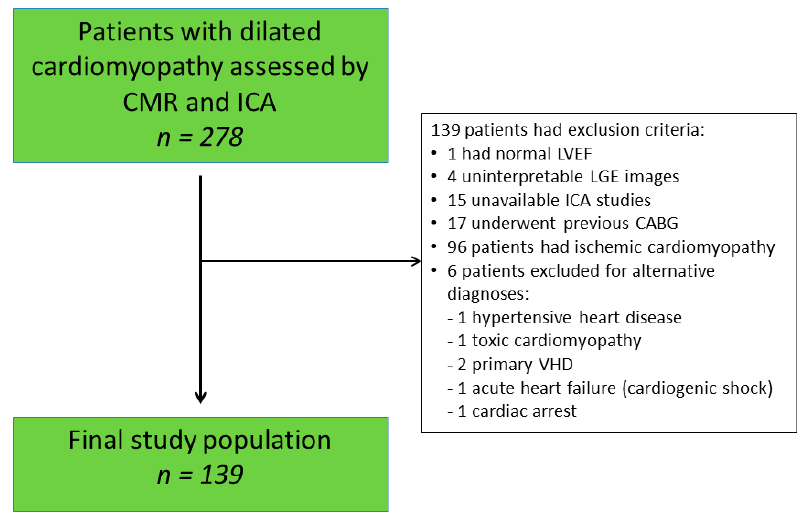
Figure 1. Flow chart of study. VHD: valvular heart disease. LVEF: left ventricular ejection fraction; CMR: cardiovascular magnetic resonance imaging; ICA: invasive coronary angiography; LGE: late gadolinium enhancement; CABG: coronary artery bypass grafting.